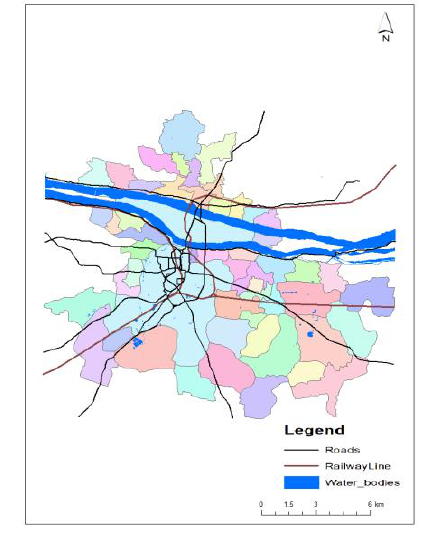
Figure 1. Study Area Location